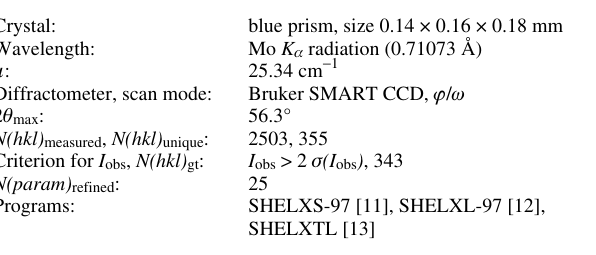
Table 1. Data collection and